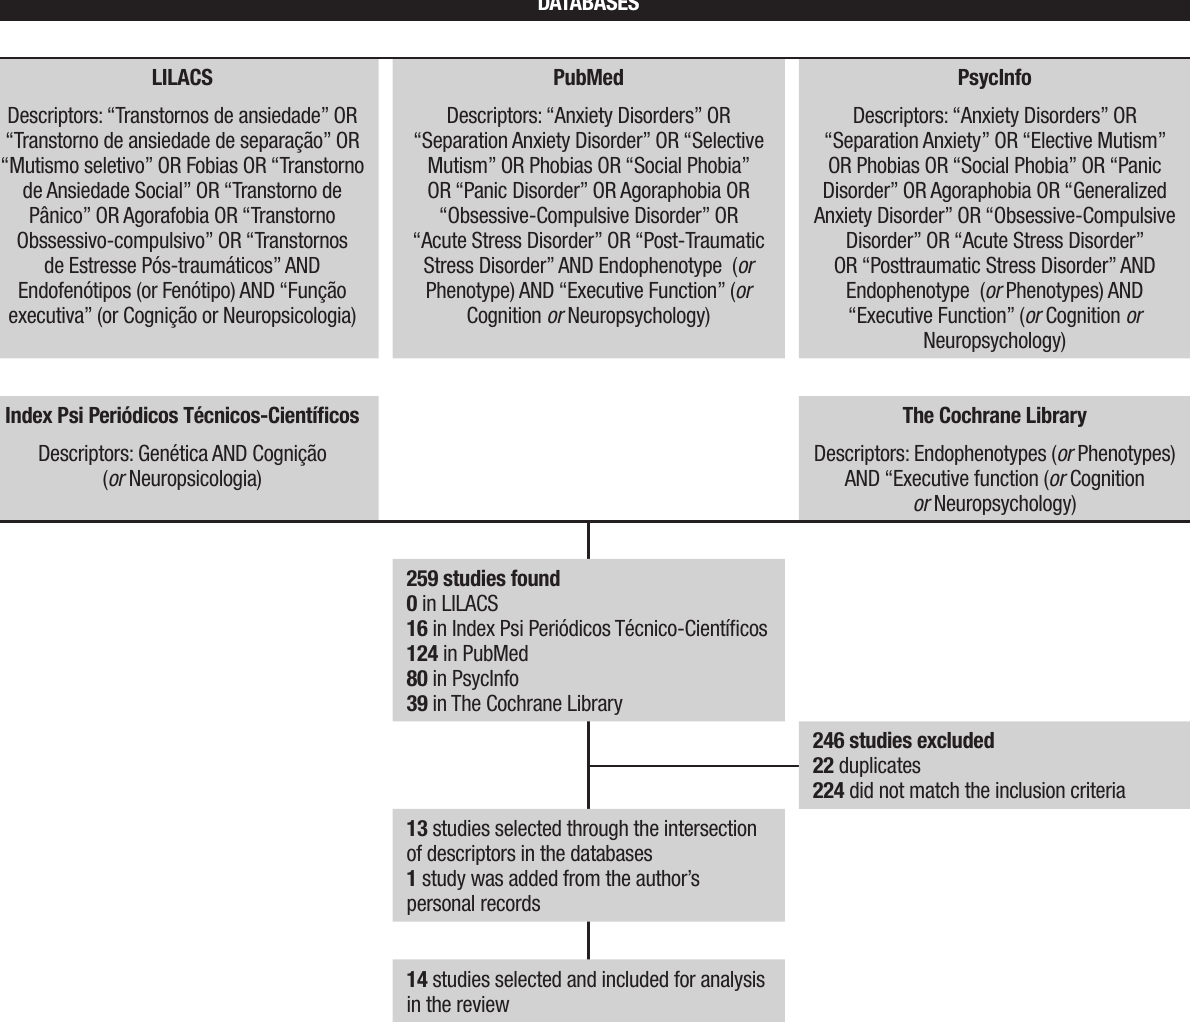
Figure 1. Flowchart with studies selection steps forming this systematic